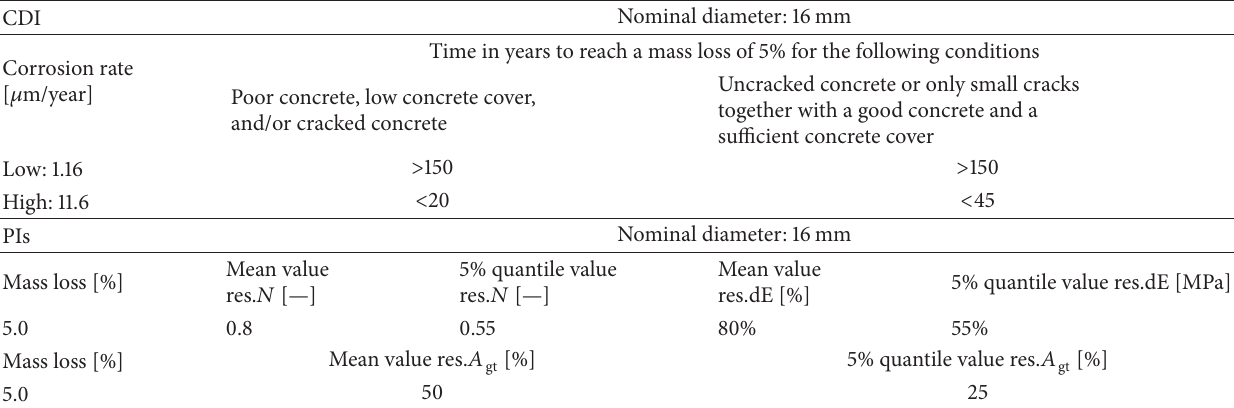
Table 8: Relation of CDI and PIs for practical corrosion